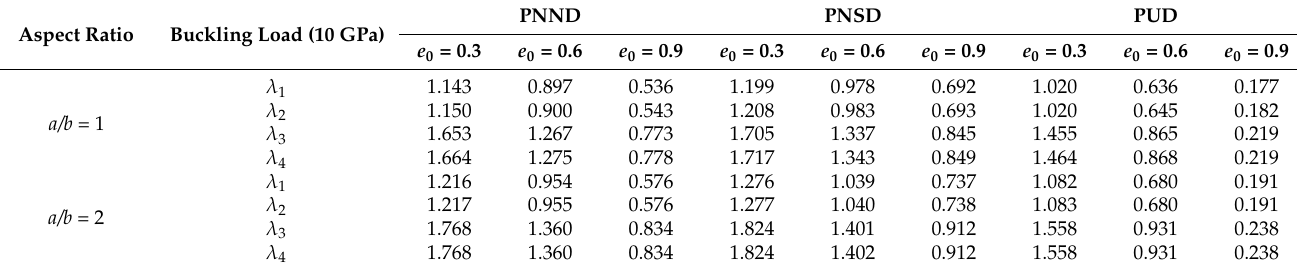
Figure 3. Comparative evaluation of the first three buckling mode shapes for a SSSS homogenous plate under a biaxial compression. Table 3. First four shear buckling loads for a FCFC FG-saturated porous plate with different aspect ratios, a / b , porosity distributions and porosity coefficients, e 0 , keeping β = 0.6 fixed.